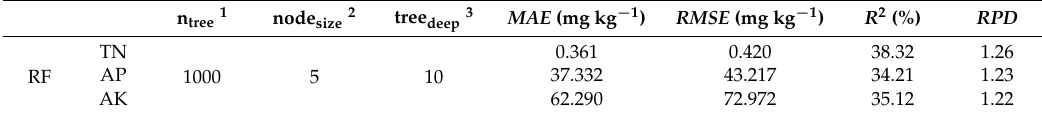
Table 4. The prediction results of soil nutrients using Random Forest (RF)